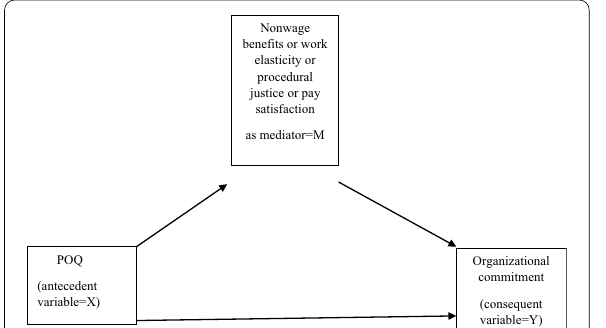
Fig. 4 Conceptual model for the mechanism through which POQ affects organizational commitment (hypotheses